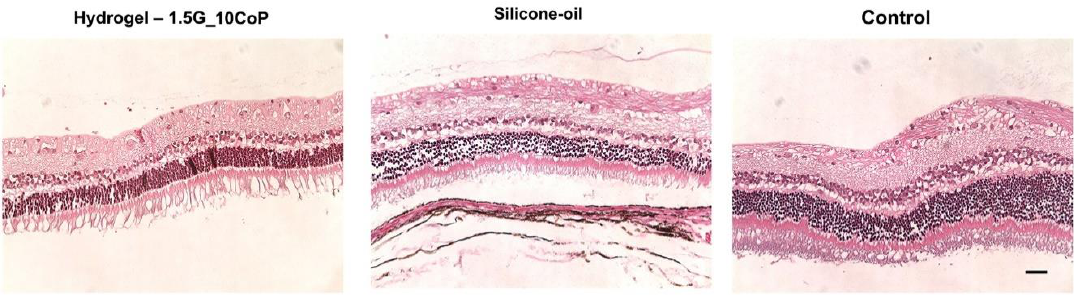
Figure 7. H&E staining on polyelectrolyte #1, silicone-oil, and control (BSS). The retina is detached from the pigmented layer. The retinal layers are clear, with no significant difference compared with the control (non-surgical eyes). The scale bar is 50 μm.